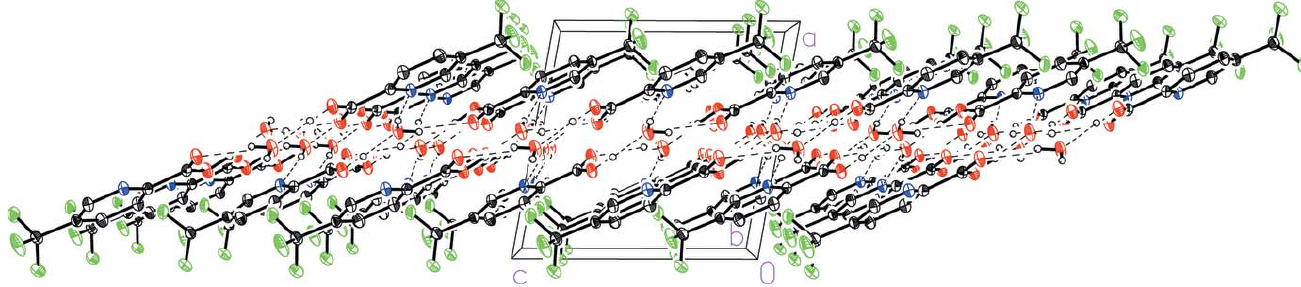
Figure 5 An edge-on view of the two-dimensional sheet formed between the water-bridged hydrogen-bonding dimers in 5-(trifluoromethyl)picolinic acid (I) hydrate.